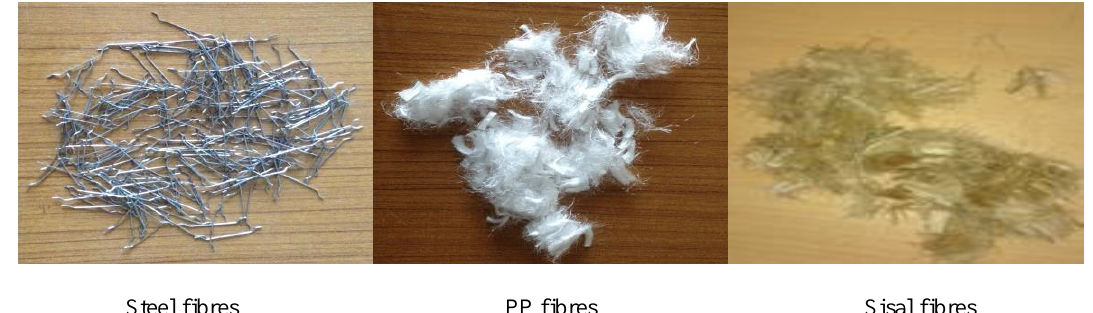
Figure 1. Different fibres used in the experimental